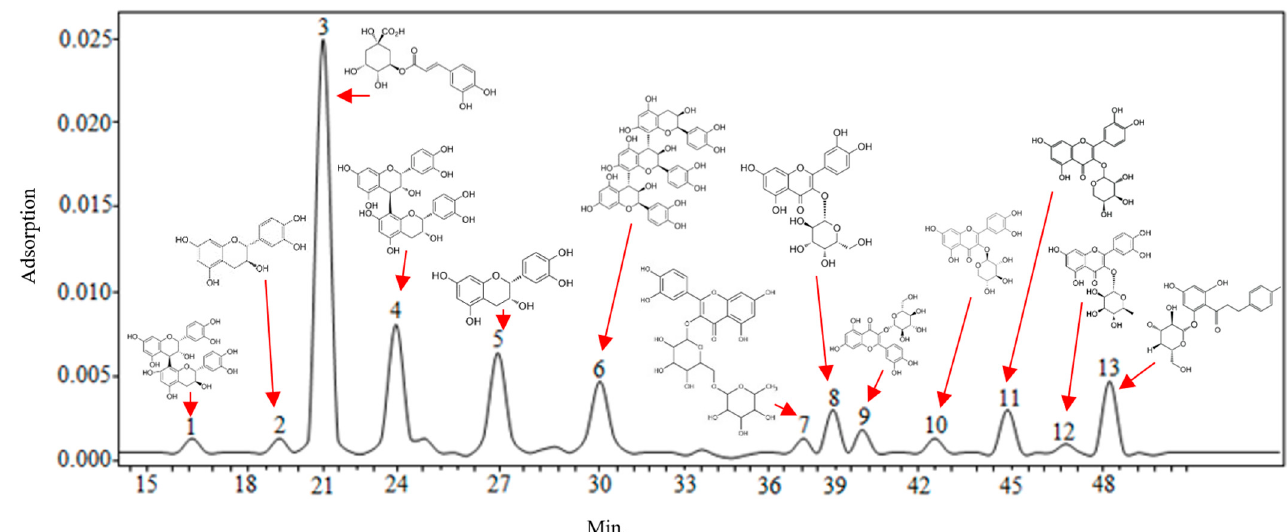
Figure 1. Chromatogram of the ethanol extract of the apple lyophilisate. Analytes determined at λ = 280 nm wavelength: